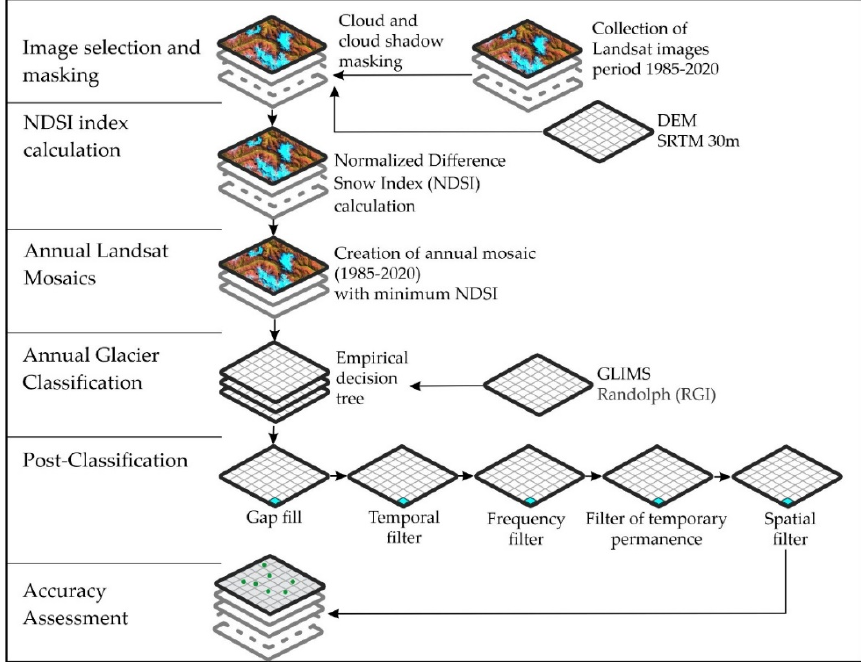
Figure 2. Methodological steps for the TAGs classification implemented in Google Earth